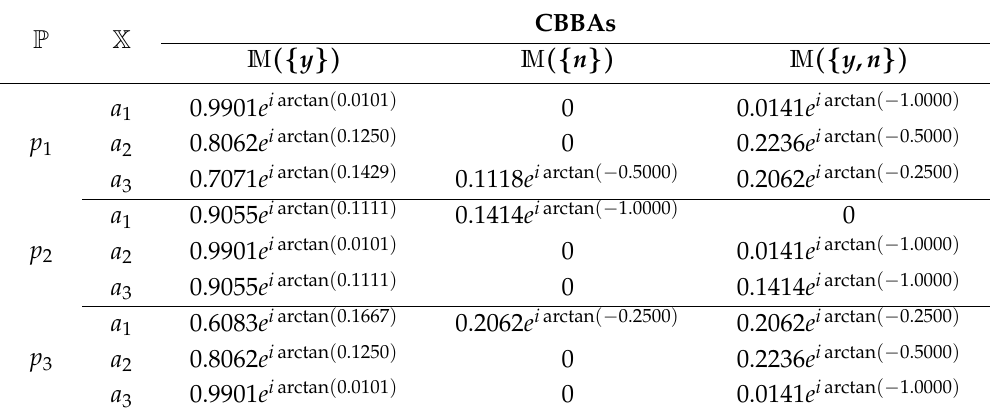
Table 3. The given patterns with multiple attributes modeled as CBBAs in the application.